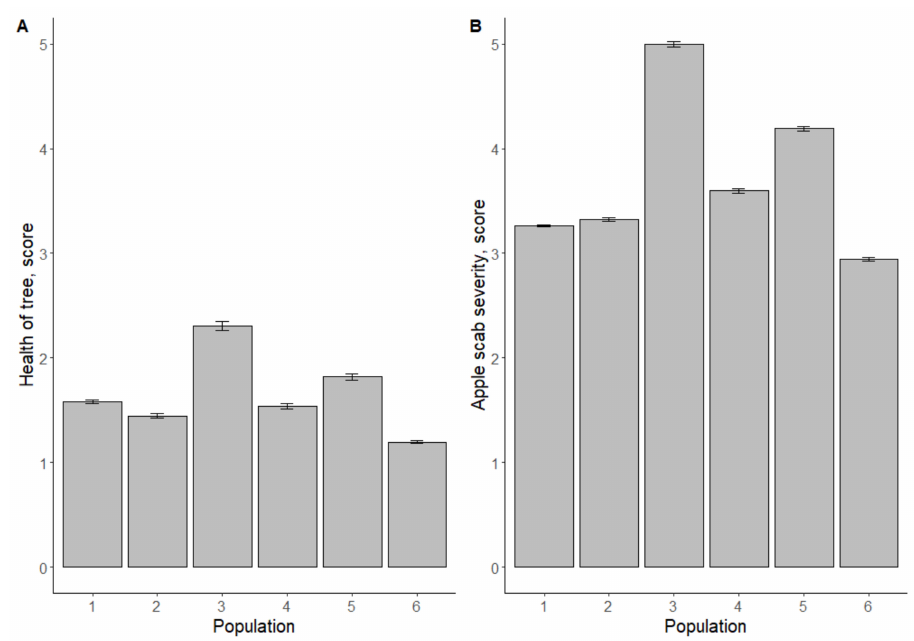
Figure 2. Average health status of trees ( A ) and scab severity ( B ) in different hybrid seedling populations (population designations are given in Table 1).